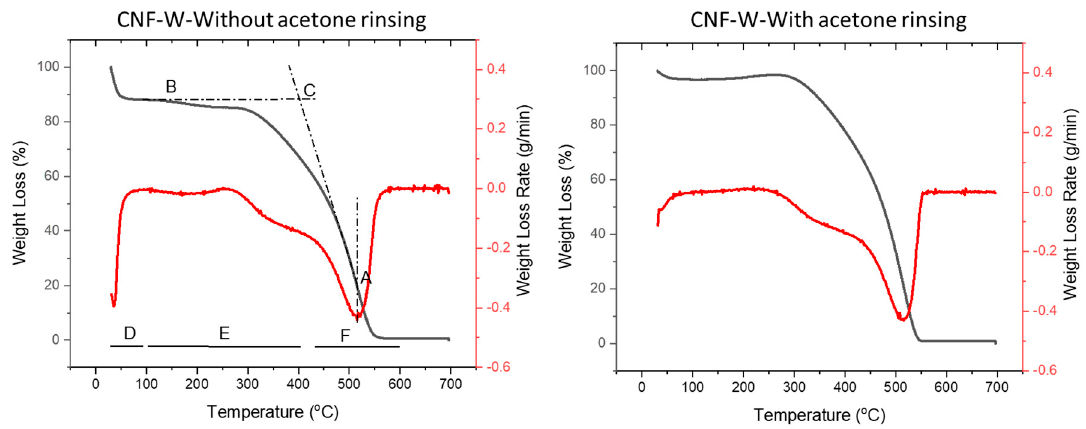
Figure 4. Thermogravimetry-digital thermogravimetry (TG-DTG) curves of cellulose nanofiber (CNF) hydrochars.